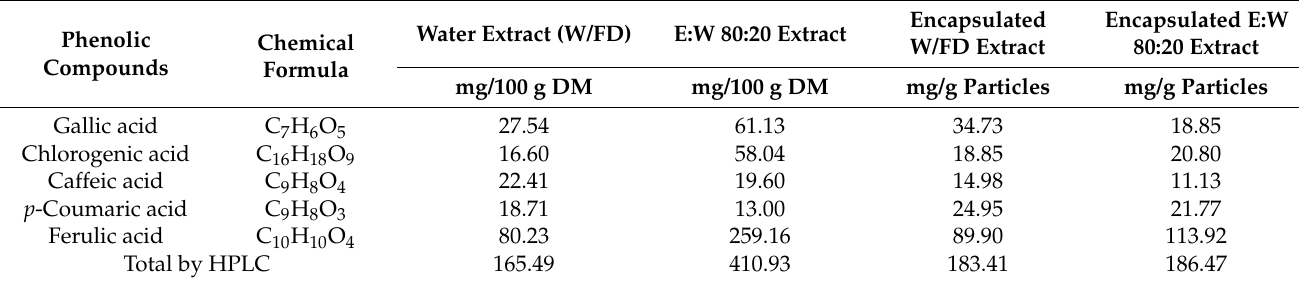
Table 6. Quantification of phenolic compounds in the extracts of pineapple peel (mg/100 g dry matter (DM)) and in particles from spray drying (mg/g